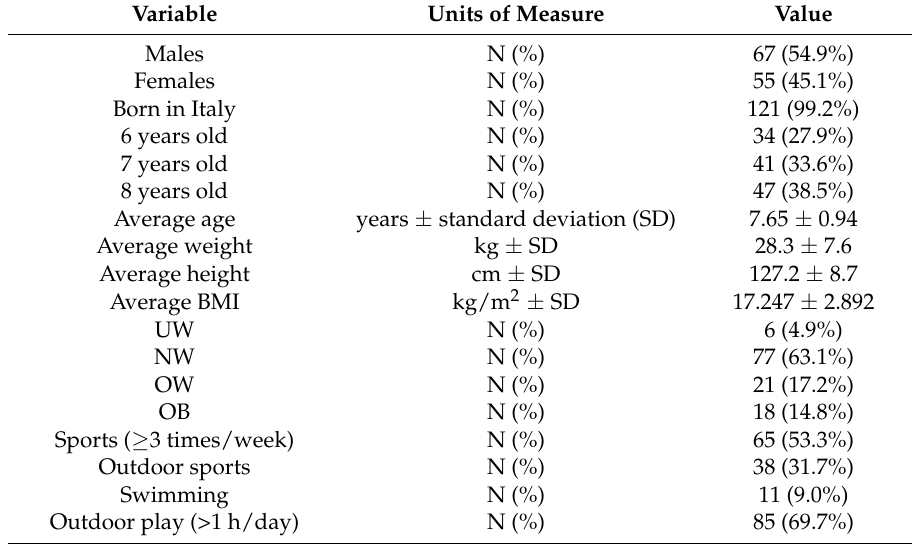
Table 1. Data on the personal and behavioral variables of the children participating in the study.